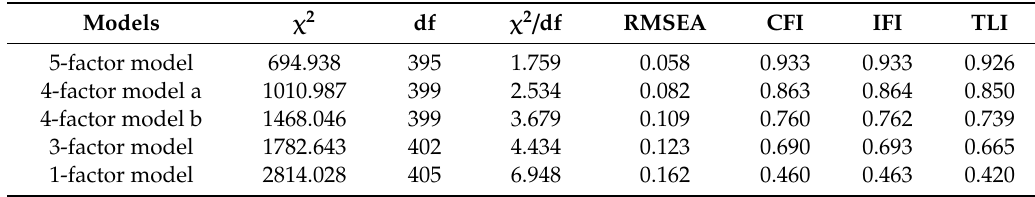
Table 1. Confirmatory factor analyses in the